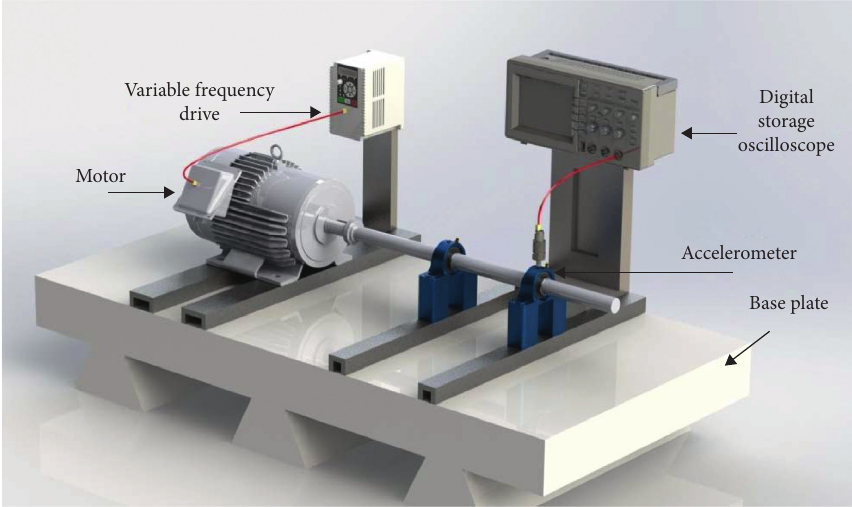
Figure 2: Experimental